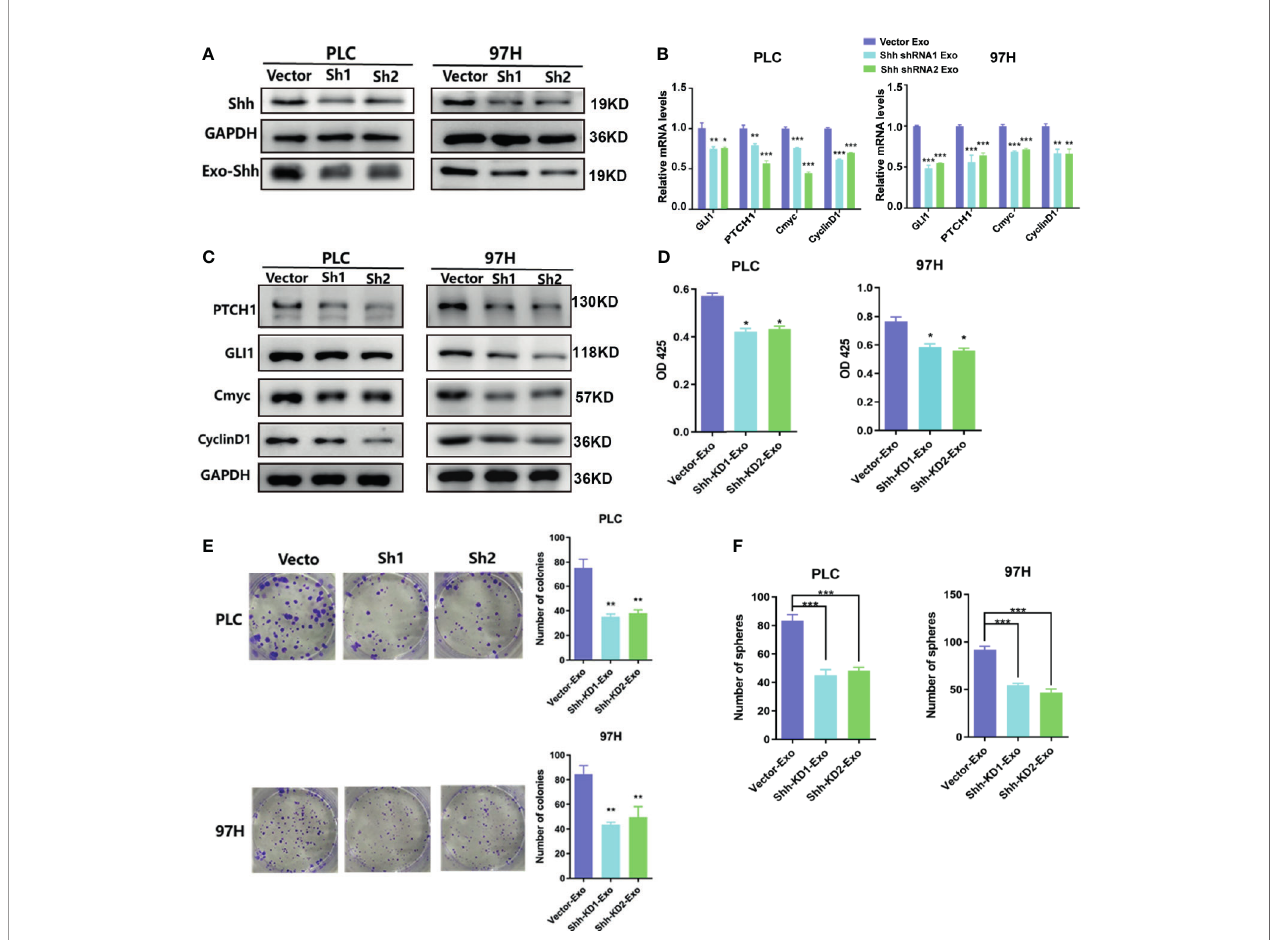
FIGURE 4 | The effect of exosomes isolated from Shh knockdown cells. (A) Western blot analysis on the transfection of Shh shRNA lentivirus on the expression of cellular Shh and Exo Shh. (B) Quantitative PCR analysis of the mRNA levels, and (C) Western blot analysis of the protein levels of hedgehog signaling pathway target genes in PLC/PRF/5 and MHCC-97H cells cultured with exosomes isolated from the culture medium of the same cell line that were transfected with vector or shRNA containing lentivirus. (D) Cell proliferations as measured by CCK8 assay, (E) colony formation assay, and (F) count of sphere formed in PLC/PRF/5 and MHCC-97H cells cultured with exosomes isolated from the culture medium of the same cell line that were transfected with vector or shRNA containing lentivirus. The data are presented as an average of three biological replicates. * p < 0.05, ** p < 0.01, *** p <